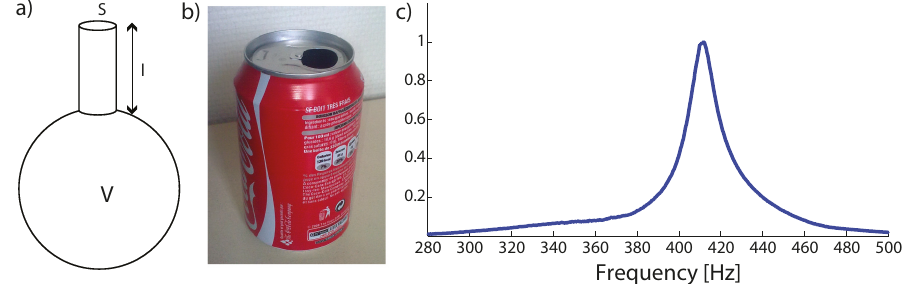
Figure 1. ( a ) A basic Helmholtz resonators with the important parameters; ( b ) The chosen experimental resonator: A soda can; ( c ) Experimental measurment of the resonance frequency measured with a microphone inside the